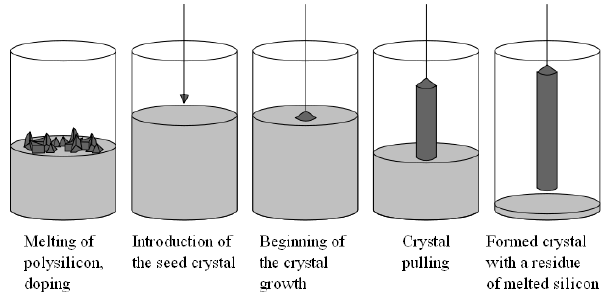
Figure 1: The main batch steps of the CZ process. Il- lustration from Wikipedia (the illustration is released to public domain by the copyright holder).